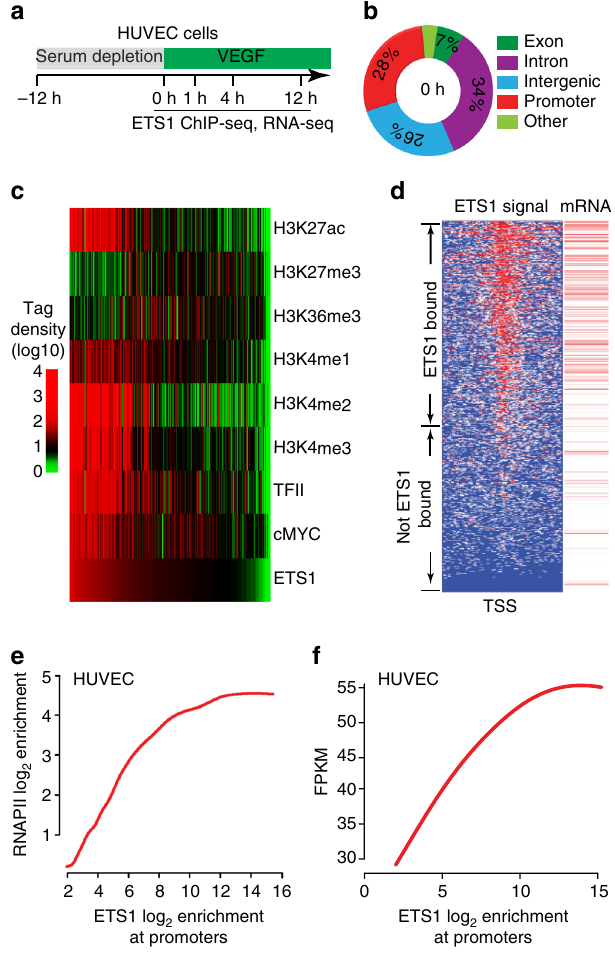
Fig. 1 ETS1 promoter occupancy and gene expression. ETS1 occupied promoters of most expressed genes, and its promoter occupancy correlated with gene expression. a Overview of the experimental design used for in vitro studies. Samples were collected prior to stimulation (0 h) and at 1, 4, and 12 h of VEGF stimulation. b ETS1 chromatin occupancy at 0 h with respect to genome annotations. c Heatmap of indicated chromatin features at promoter regions at the 0 h time point. Regions are ordered by ETS1 binding strength at 0 h after VEGF stimulation. Features positively correlated with gene expression correlated with ETS1 binding strength. d ETS1 signal at TSS region and associated gene expression at the 0 h time point. ETS1 bound most expressed genes. Left panel (ETS1 signal): tag heatmap with high ChiP-seq signal shown in red . Right panel (mRNA): red lines indicate expressed genes, as determined by RNA-seq. e Correlation plot of promoter ETS1 and RNAPII occupancy at the 0 h time point. f Correlation plot of promoter ETS1 occupancy and RNA-seq gene expression at the 0 h time